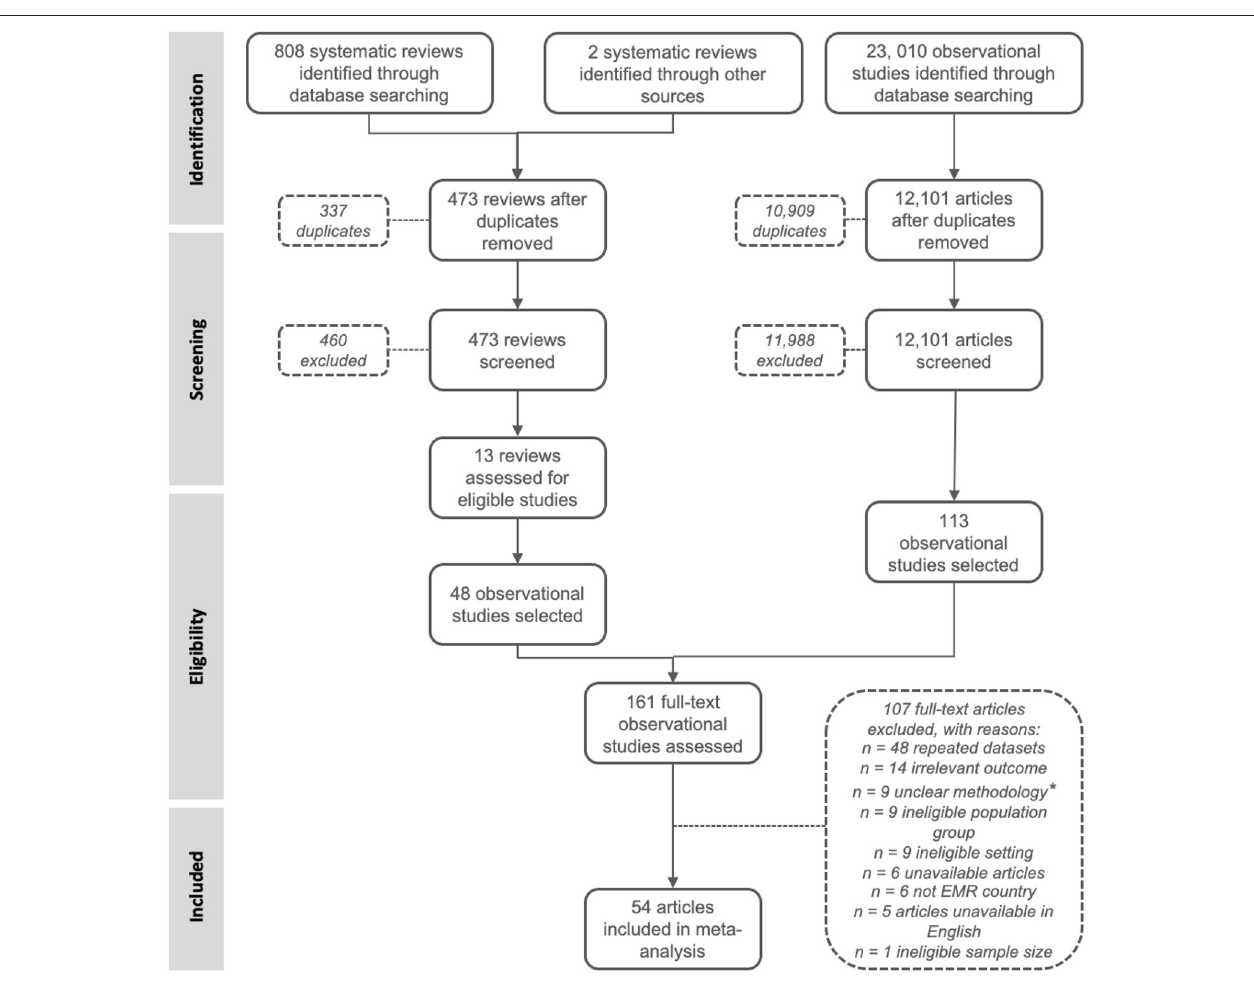
FIGURE 1 | Flowchart. *studies that weren’t transparent about their methodologies, setting and time